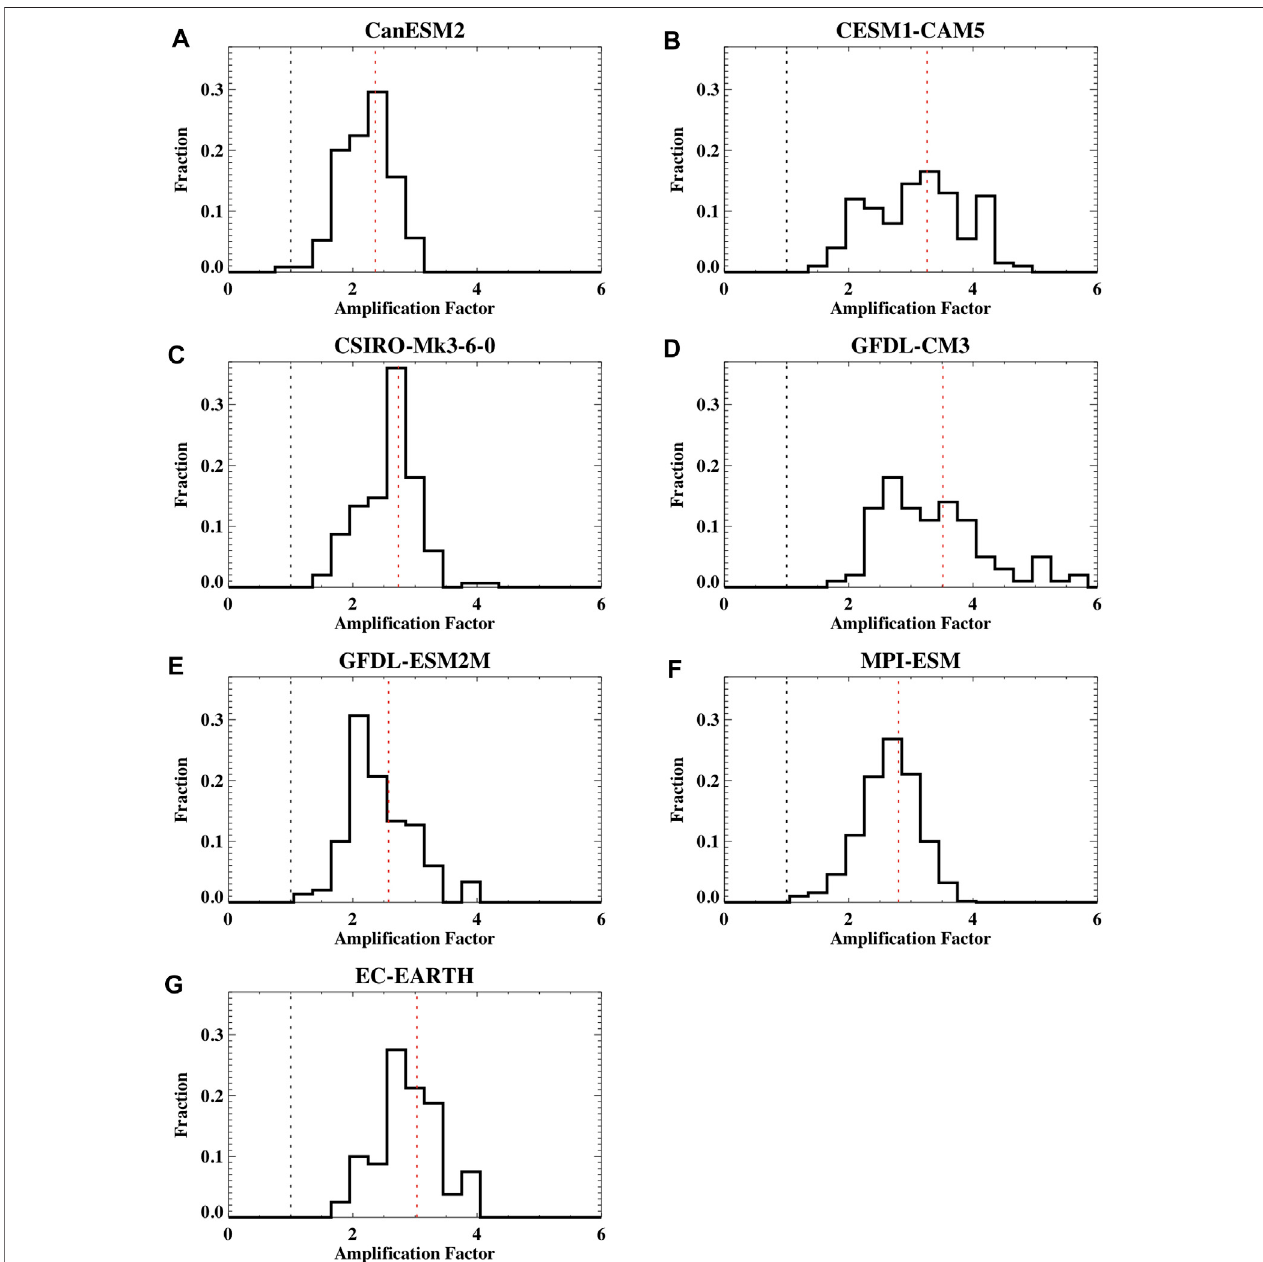
FIGURE 5 | The histogram of the annual mean Arctic ampli fi cation factor at the ToE across the different ensemble members for each SMILE including (A) CanESM2, (B) CESM1-CAM5, (C) CSIRO-Mk-3-6-0, (D) GFDL-CM3, (E) GFDL-ESM2M, (F) MPI-ESM, and (G) EC-EARTH. A value of one (no ampli fi cation) is shown for reference in the black dotted line. The average ampli fi cation factor at the ToE is shown in the red dotted line.